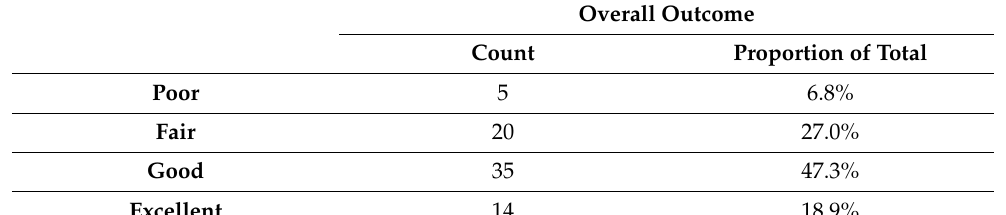
Table 7. Mean overall outcome/satisfaction.